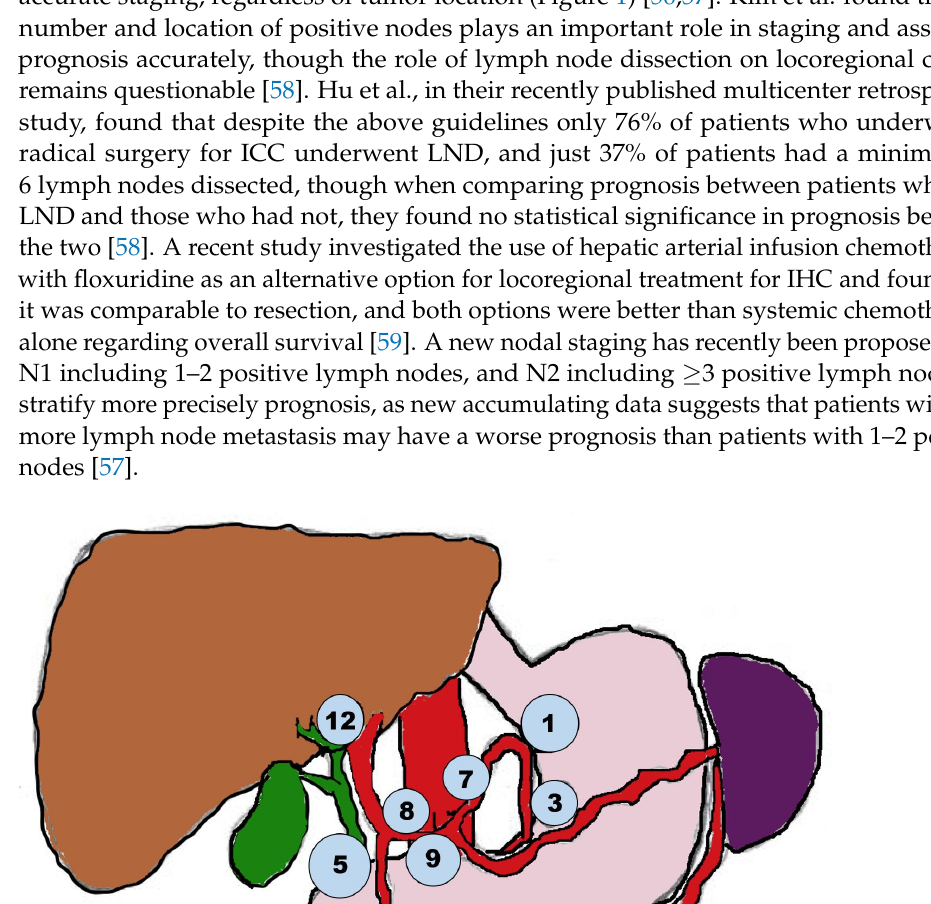
Figure 1. Lymph node locations for ICC